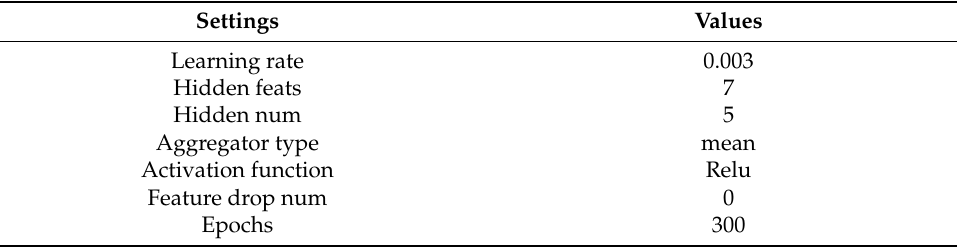
Table 3. Settings of the GNN training. Settings Values Learning rate 0.003 Hidden feats 7 Hidden num 5 Aggregator type mean Activation function Relu